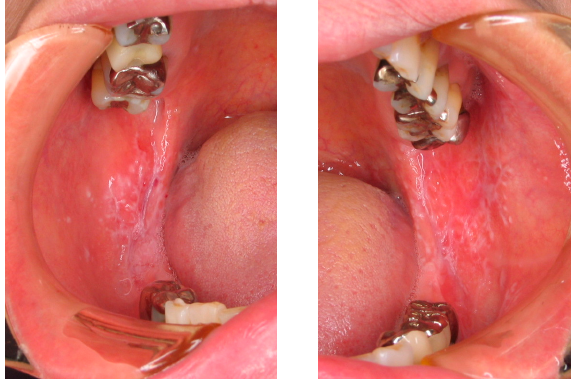
Figure 2. Oral lichen planus (OLP) in a patient, which occurred on both sides of the buccal mucosa with a white and papuloreticular lesion.